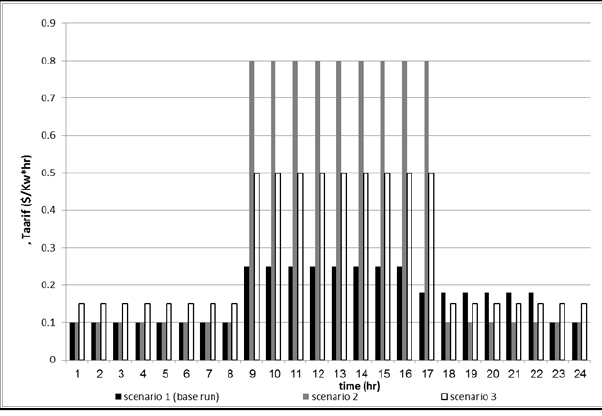
Figure 8. Description of different electricity tariffs.